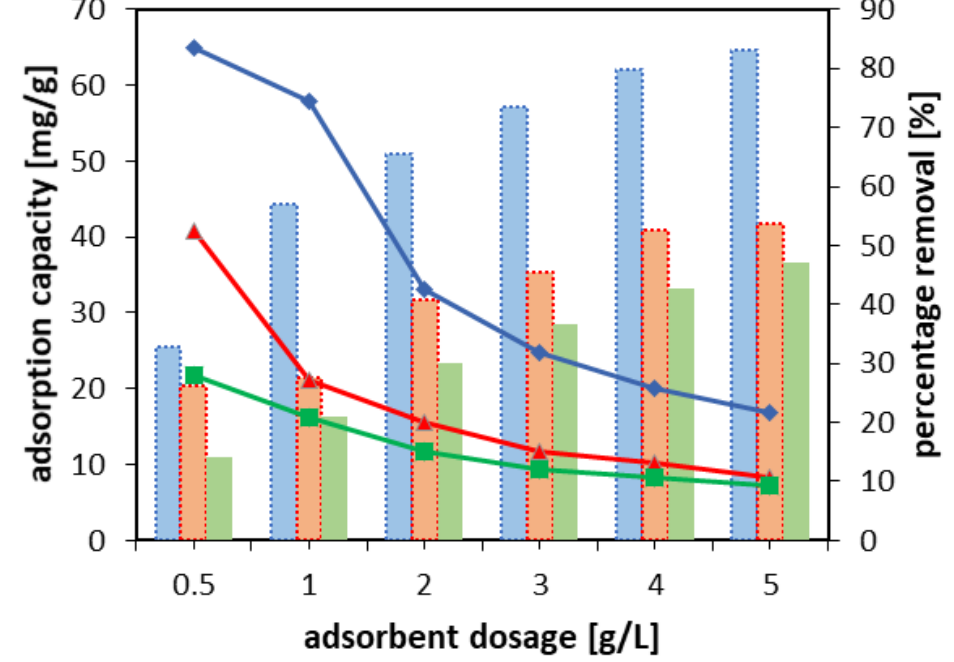
Figure 7. The effect of the adsorbent dosage, V = 25 mL, C 0 = 100 mg/L; lines, attributed to adsorption capacity (mg/g), NaX-CD (blue); NaA-CD (red); NaP1-CD (green); bars, to percentage removal (%), NaX-CD (blue); NaA-CD (orange); NaP1-CD (green).